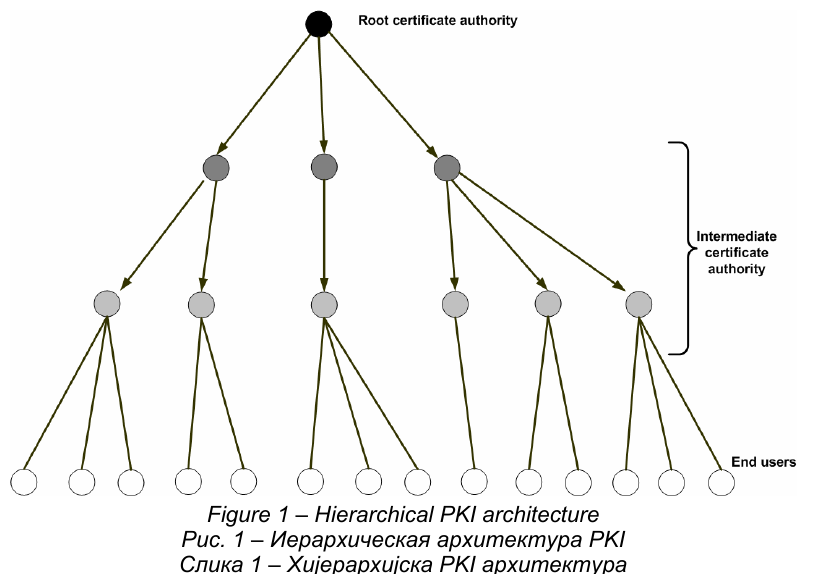
Figure 1 – Hierarchical PKI architecture Рис . 1 – Иерархическая архитектура PKI Слика 1 – Хијерархијска PKI